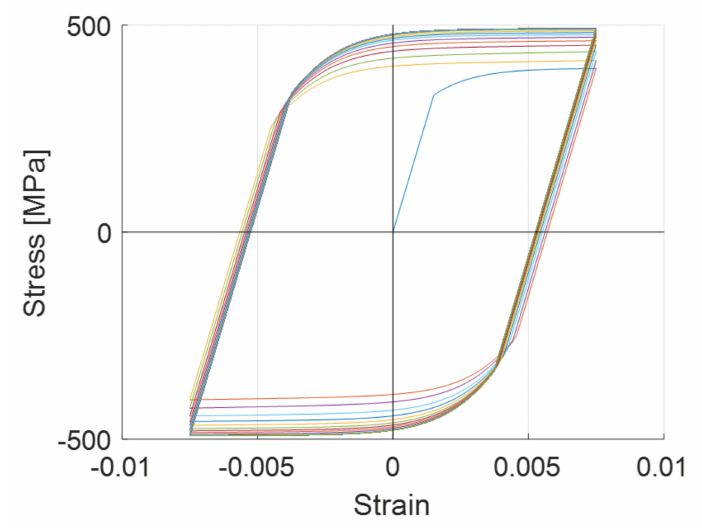
Figure 6. Stress–strain curves of a uniaxial, symmetric strain-controlled, cyclic test. By specifying the combined hardening coefficient m , computational stress–strain curves based on the analytical model of Equations (1)–(11) with the strain range ∆ ε of 0.0015 can be obtained. For a nine-roll roller leveler, the total number of bends equals seven. The values of the combined hardening coefficient m for the seven bends can be calibrated by comparing the computational stress–strain curves with the stress–strain curves of the mild steel shown in Figure 6 for the first seven bend loadings. Figure 7 shows the computational stress–strain curves and the stress–strain curves of Figure 6. The computational curves agree with those of the mild steel. The calibrated m values for the second to the seventh bending are 0.0784, 0.2, 0.3, 0.4, 0.45, and 0.5, respectively. The hardening behavior of the material for the first bending is taken as isotropic.